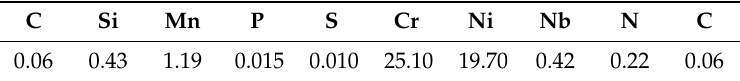
Table 1. Chemical composition of the test steel,